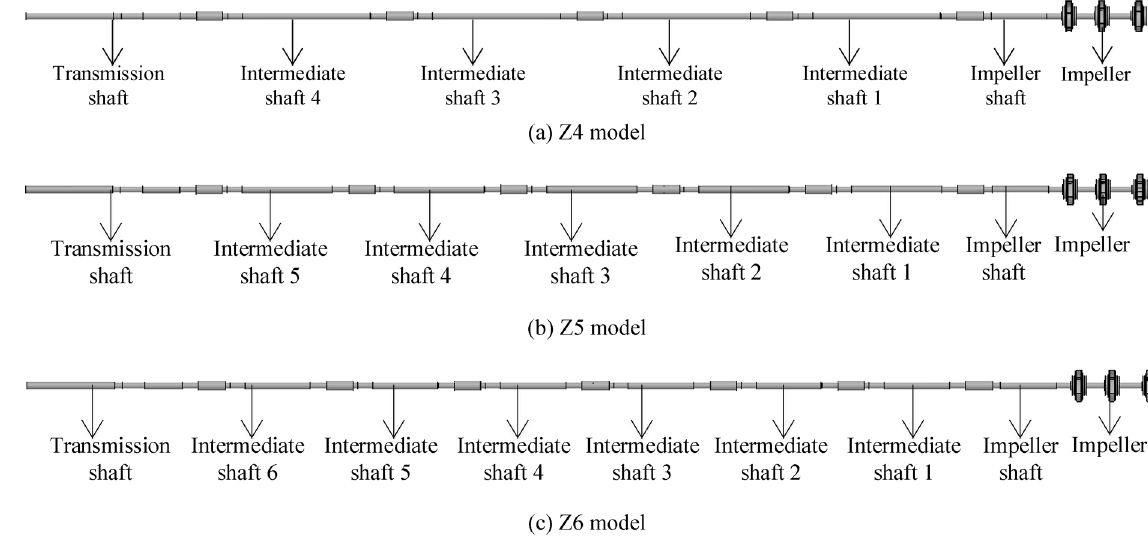
Figure 9. Three models of the VLSFP shafting rotor.